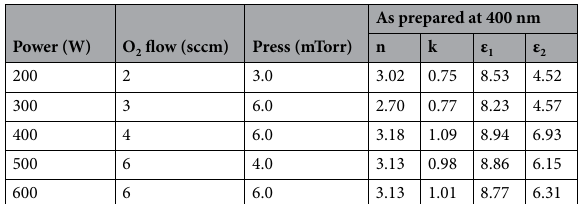
Table 4. Tabulated optical constants in the visible region at different deposition conditions as prepared at 400 nm.